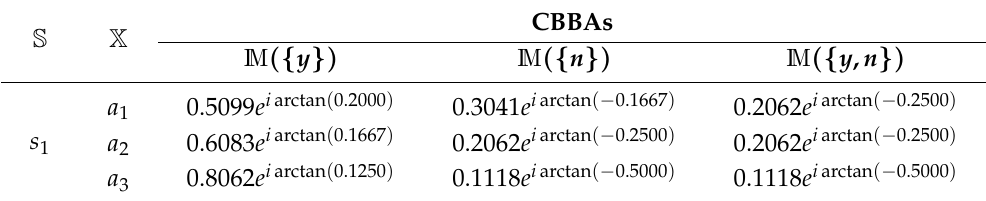
Table 4. To be determined sample with multiple attributes modeled as CBBAs in the